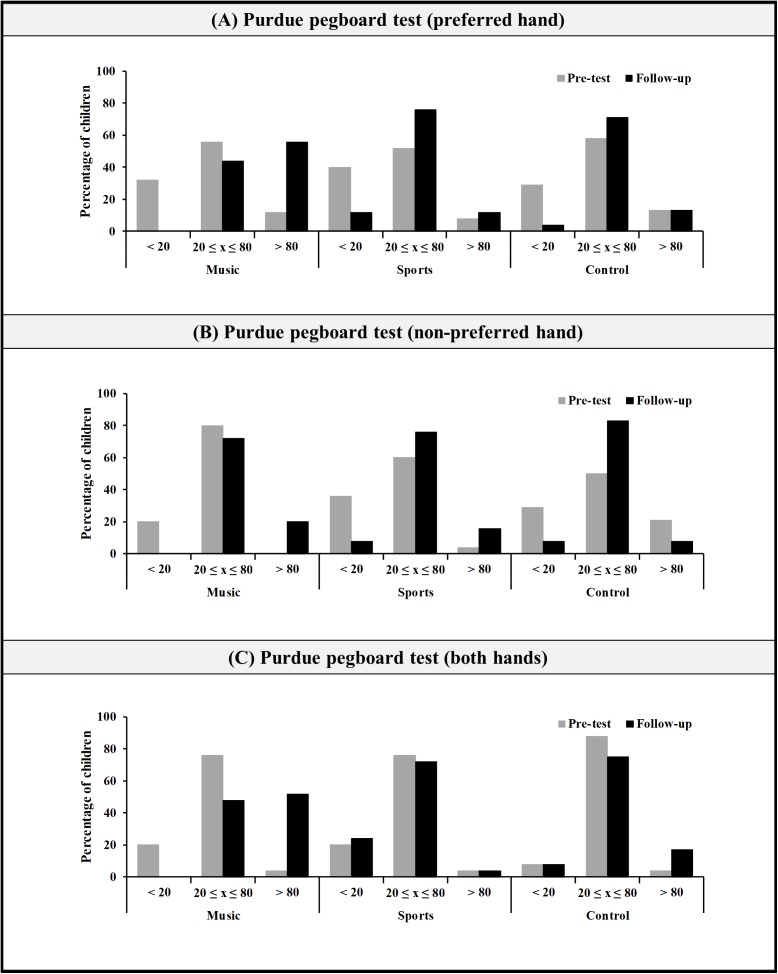
Distribution of children from the three groups according to performance levels: low (<20th percentile), middle (20th–80th percentile), and high (>80th percentile), in the Purdue pegboard test with the preferred hand (A), non-preferred hand (B), and both hands (C).